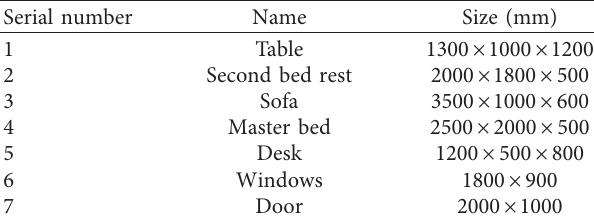
Table 2: Size table of type B